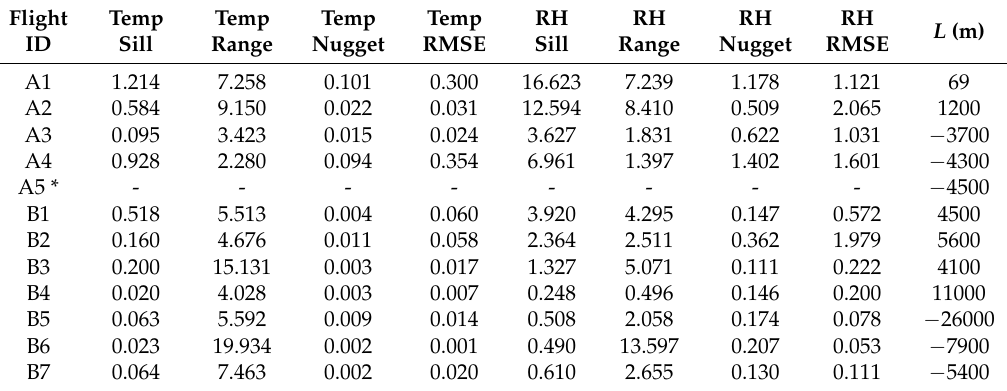
Table 2. Variogram results and fit diagnostics (RMSE) for all flights showing sill, range, and nugget values for temperature (Temp) and relative humidity (RH) and estimates of the Monin–Obukhov length scale [ L